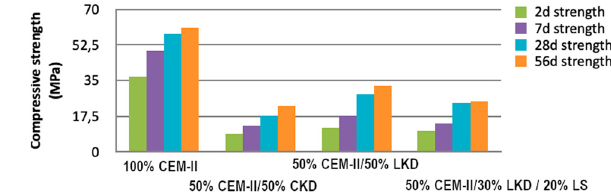
Figure 7: Compressive strength of specimens with di ff erent combi -